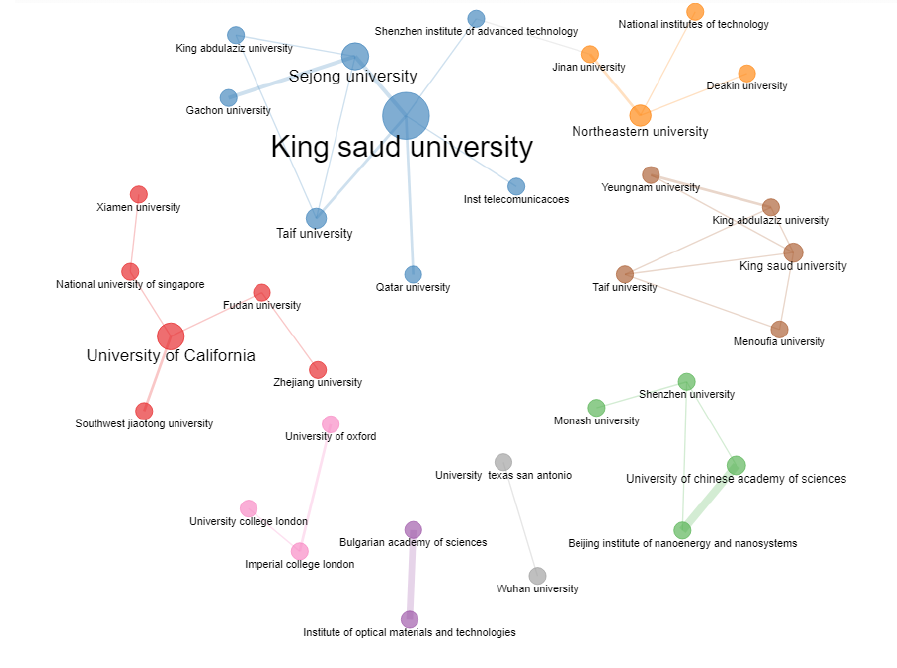
Figure 16. Collaboration network of different universities for IoMT